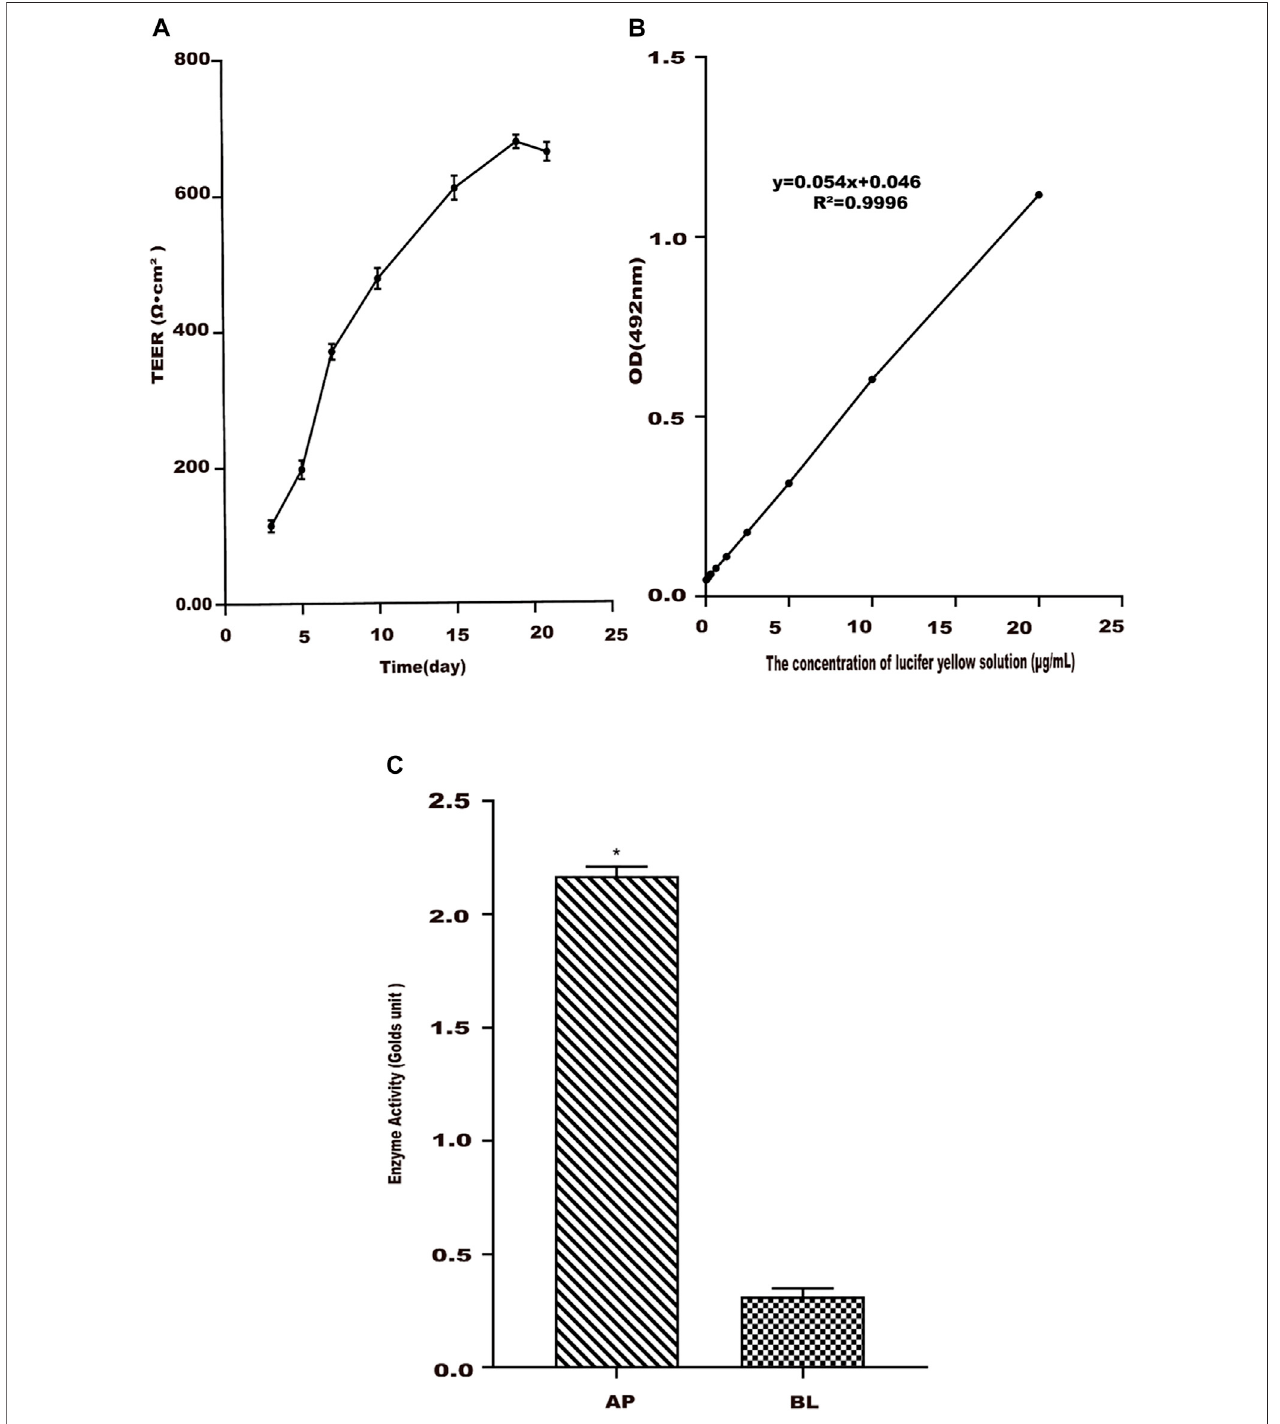
FIGURE 3 | Establishment of the Caco-2 cell transport model. (A) Change trend ofCaco-2 cell monolayer transmembrane resistance (TEER) with culture time. (B) Standard curve of lucifer yellow from the AP side to BL side in Caco-2 cells. (C) Alkaline phosphatase activities in apical (AP) and basolateral (BL) sides of Caco-2 cell monolayers. Values are presented as the means ± SD where applicable (n = 6). * p < 0.05 than the BL side.